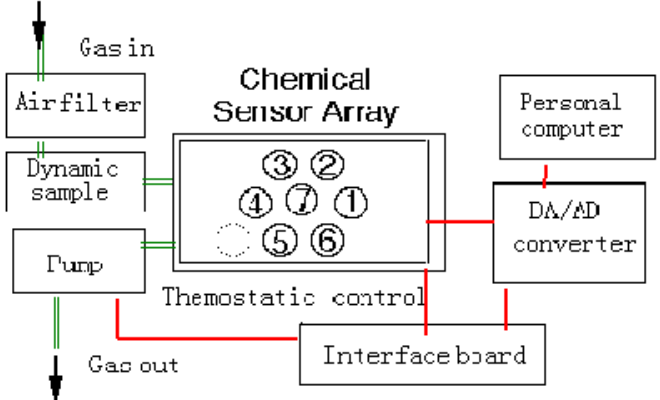
Figure 1. Schematic diagram of the electronic